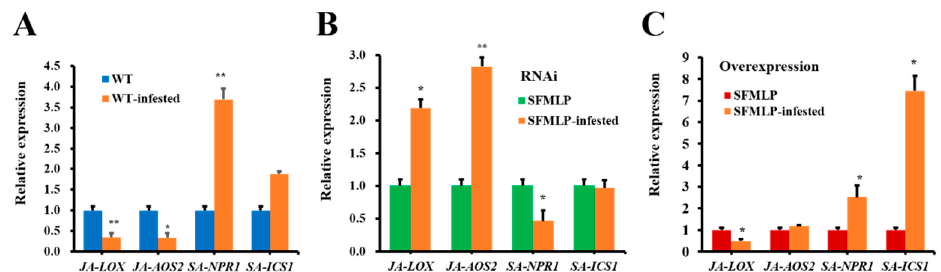
Figure 11. Relative expression levels of JA marker and SA marker genes in rice plants infested by WBPH. ( A ) The expression levels of genes in the WT plants and WT plants infested by WBPH (WT- infested); ( B ) the expression levels of genes in the SFMLP - dsRNA -transgenic plants ( dsSFMLP ) and dsSFMLP plants infested by WBPH ( SFMLP -infested); ( C ) the expression levels of genes in the SFMLP -overexpressing-transgenic plants ( SFMLP ) and SFMLP plants infested by WBPH ( SFMLP -infested). * and ** indicate statistically significant differences ( t- test: p < 0.05 and p < 0.01). Bars, ±SEM.